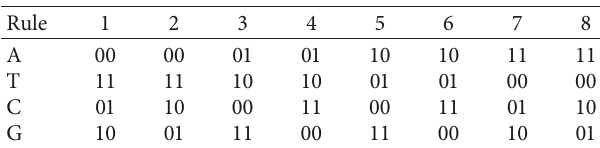
� 0.2456, μ � 0.3324, α � 2.143, and m � 2). 0 Table 1: DNA encoding